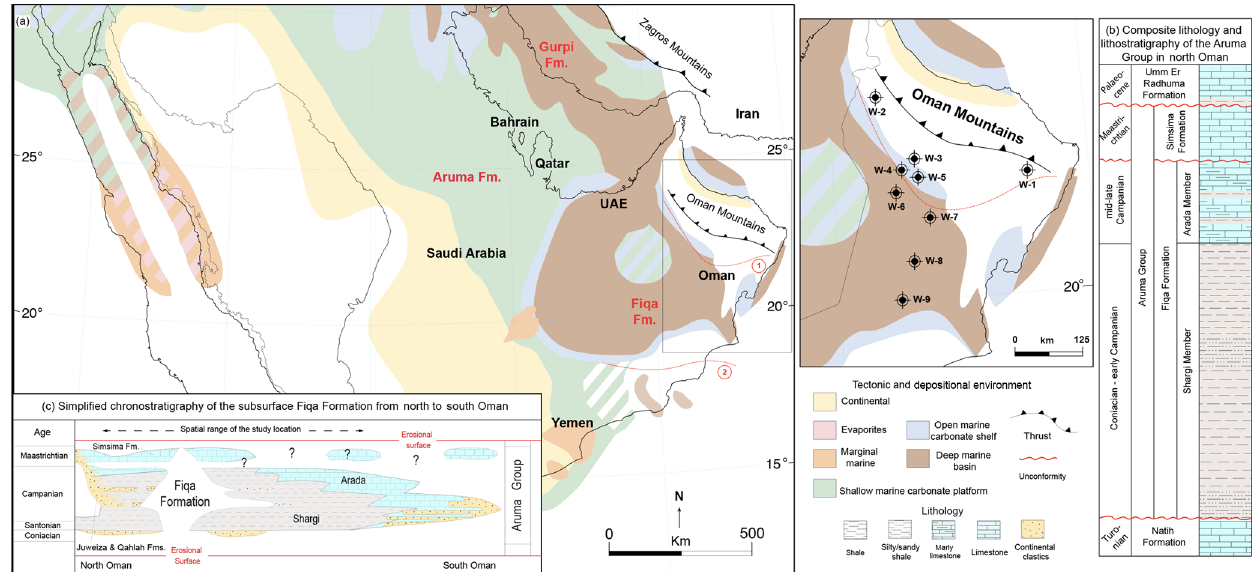
Figure 2. (a) Location of the study wells in a regional palaeofacies map of the Late Cretaceous (modified after Ziegler, 2001) showing the deposition of the Fiqa Formation and its equivalents (Gurpi and Aruma formations): (1) outline of the foredeep part of the basin in north Oman; (2) extent of the Aruma Basin in Oman. (b, c) Lithology, lithostratigraphy and chronostratigraphy of the Aruma Group in Oman (adapted from Forbes et al.,